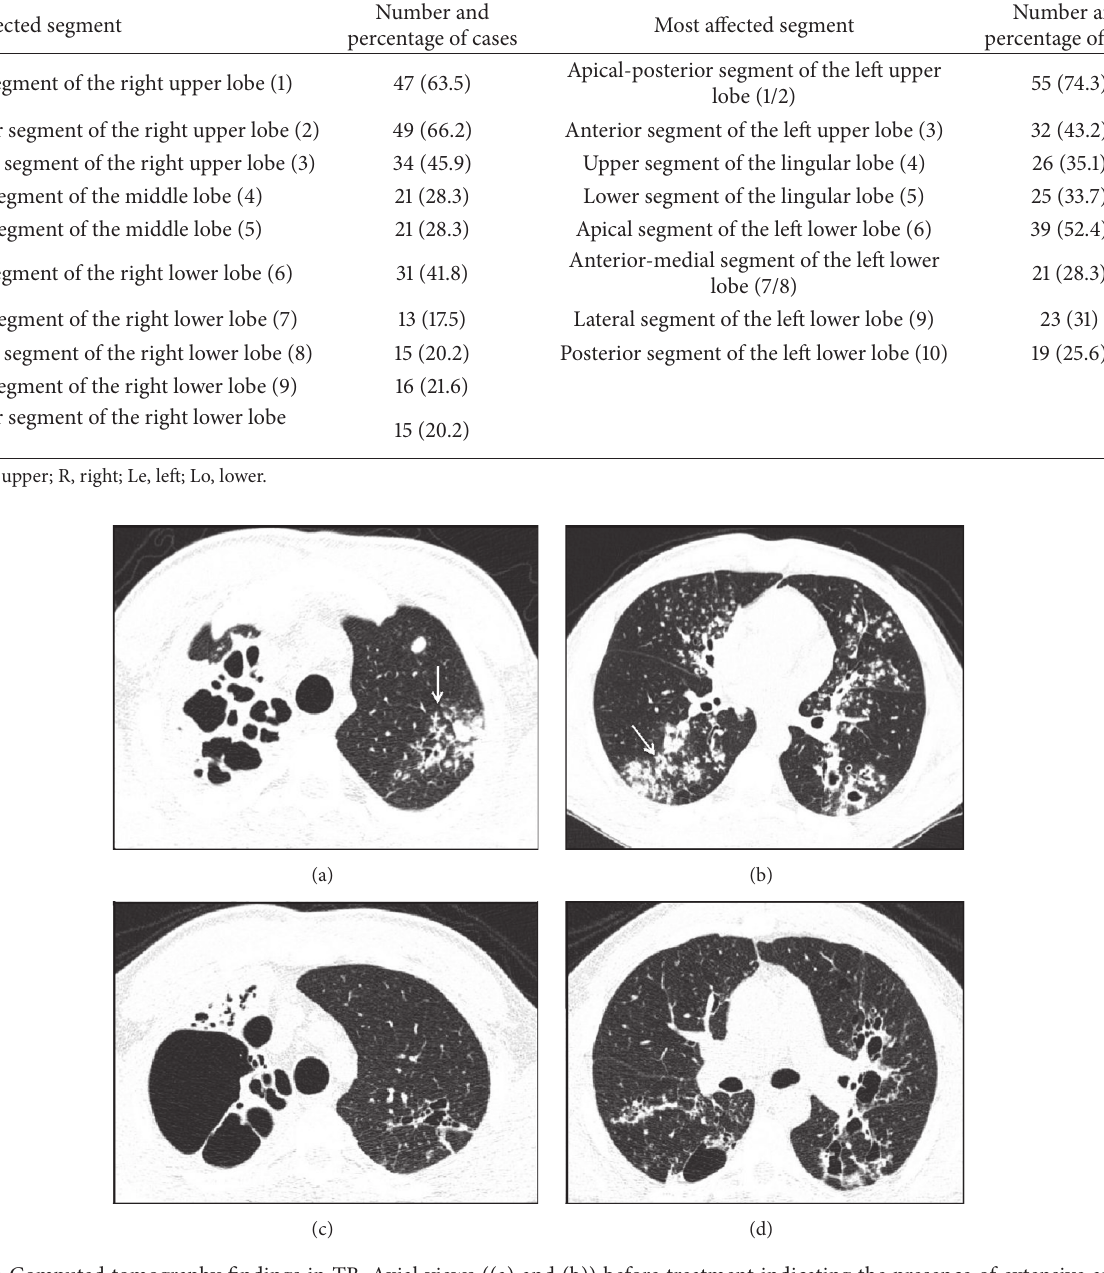
in upper lobes and occurred in upper left lobe in 22 cases (47.8%) and in upper right lobe in 15 cases (32.0%). The left and right lungs were affected separately in 12 cases